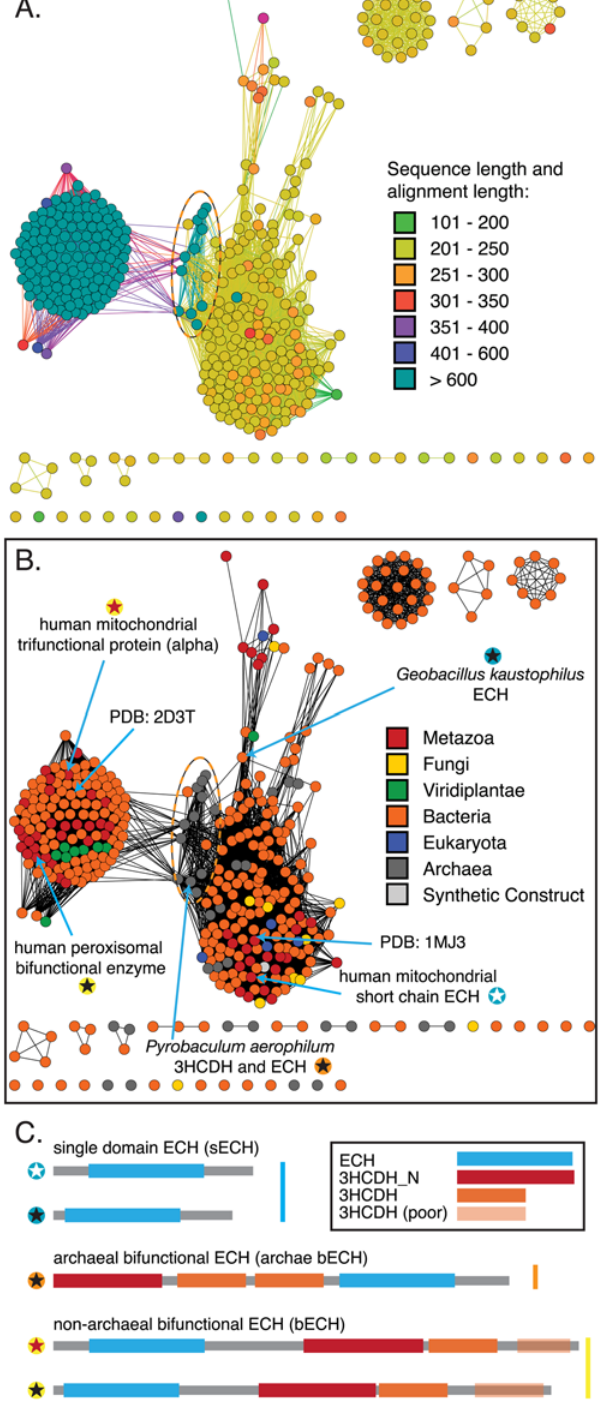
Figure 6. Domain shuffling in the enoyl-CoA hydratase family. The displayed networks contain all 410 enoyl-CoA hydratases from the crotonase superfamily network in Fig. 5A. The network is thresholded at a BLAST E-value of 1 6 10 2 50 ; the worst edges displayed correspond to a median of 40% identity over alignments of 260 amino acids. A. Network nodes colored by sequence length and edges colored by alignment length. B. Network nodes colored by species kingdom (Fungi, Metazoa, Viridplantae) or superkingdom (Bacteria, Eukaryota, Archaea). The same archaebacterial bifunctional enzymes are marked with a dashed oval in both A and B. C. Representative domain structures for the three major classes of enoyl-CoA hydratase-containing sequences, with domains defined using PFAM HMMs[36].